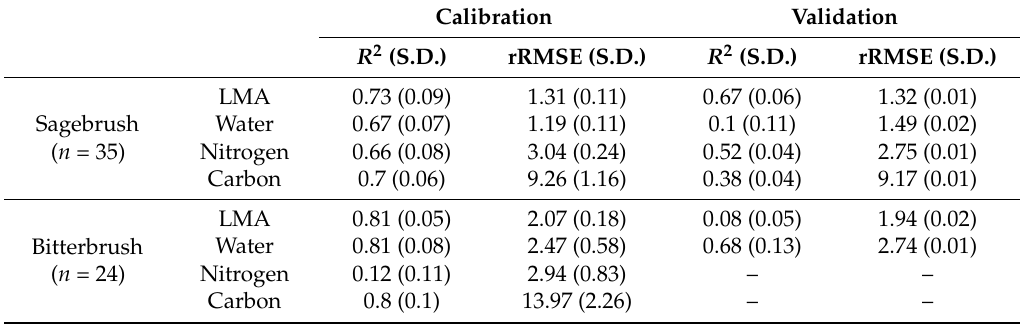
Table 4. Results of PLSR plot-level biochemical traits in sagebrush and